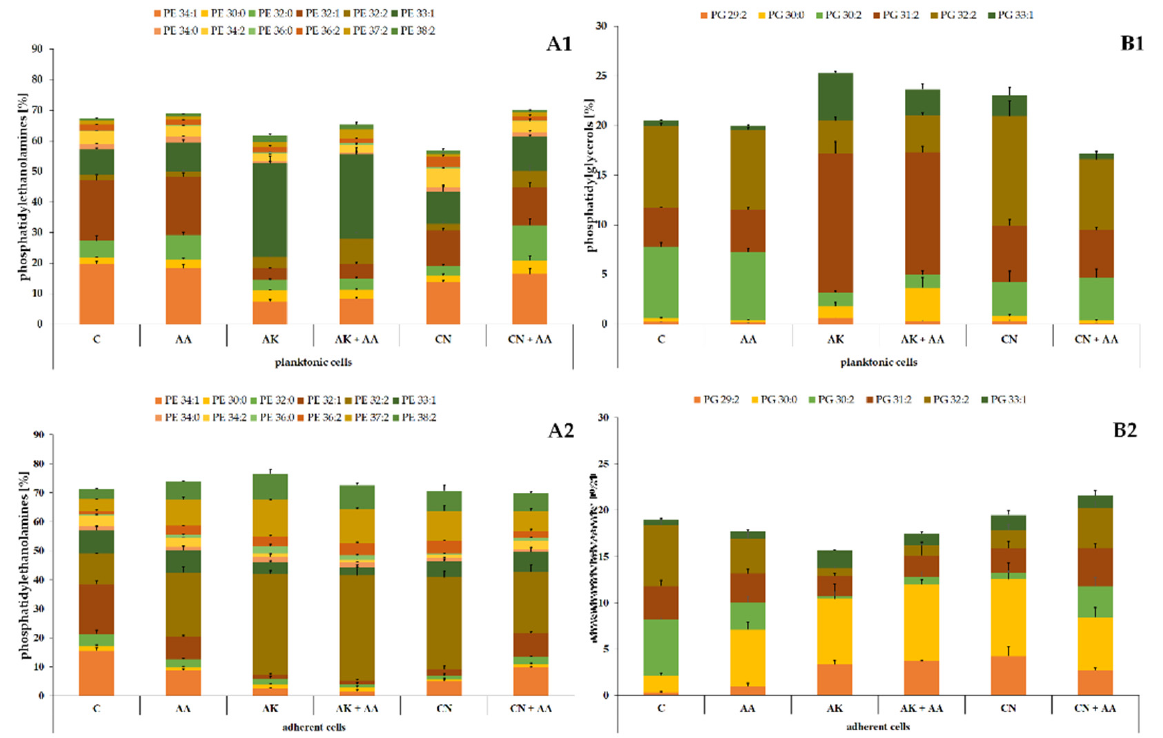
Figure 3. Percentage content of phosphatidylethanolamines ( A ) and phosphatidylglycerols ( B ) identified in the planktonic ( 1 ) and adherent ( 2 ) cells of the P. mirabilis C12 strain treated with ascorbic acid, amikacin, or gentamicin. Legend: C—control, AA—ascorbic acid, AK—amikacin, CN—gentamicin. Table 2. Statistically significant changes in the PLs levels induced by AA, AK, or CN treatment in the planktonic and adherent cells of the P. mirabilis strains, determined by Student’s t -test. ATCC 29906 Strain C12 Strain Planktonic Cells Adherent Cells Planktonic Cells Adherent Phospholipid